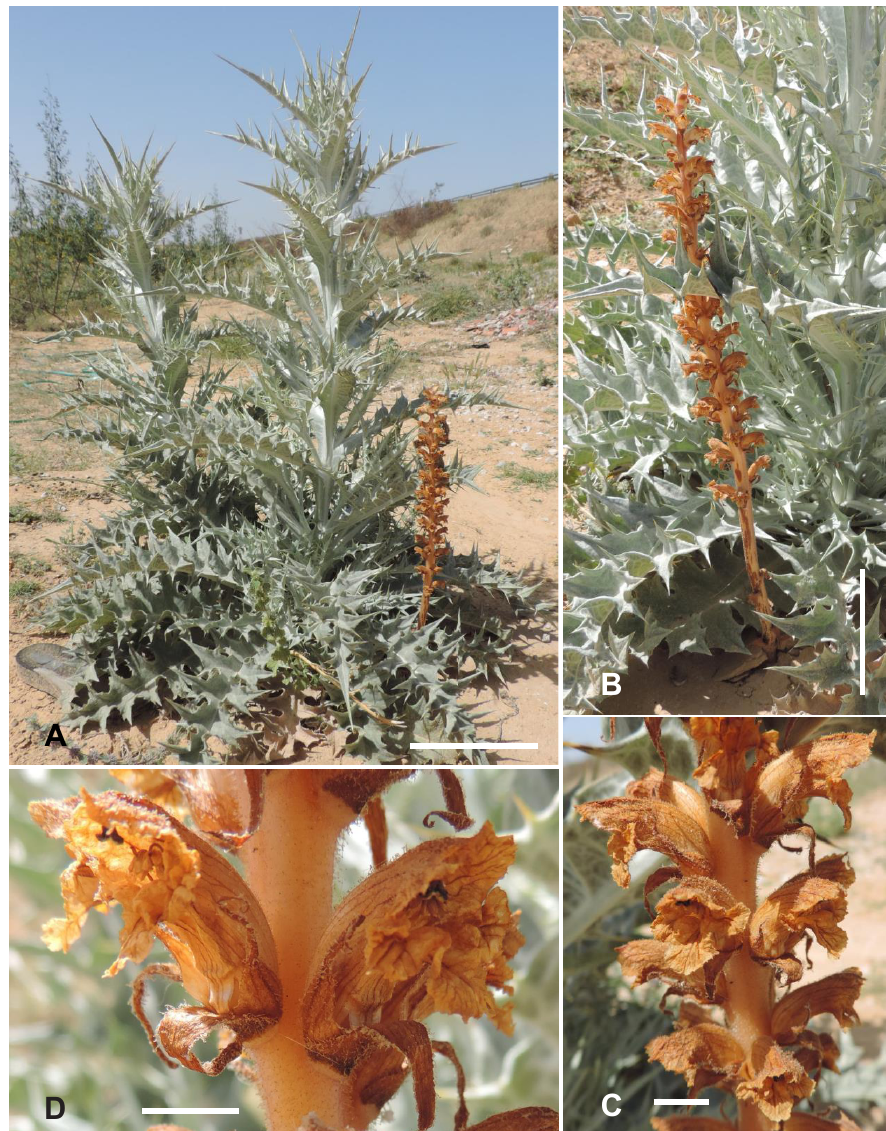
Figure 1. Orobanche dominae El Mokni sp. nov. A, Type locality (scale bar = 15 cm); B, Habit on its host species, Onopordum espinae (scale bar = 10 cm); C, Lax glandular hairy inflorescence (scale bar = 1 cm); D, Details of semi- opened flowers (scale bar = 1 cm). Photographed by R. El Mokni